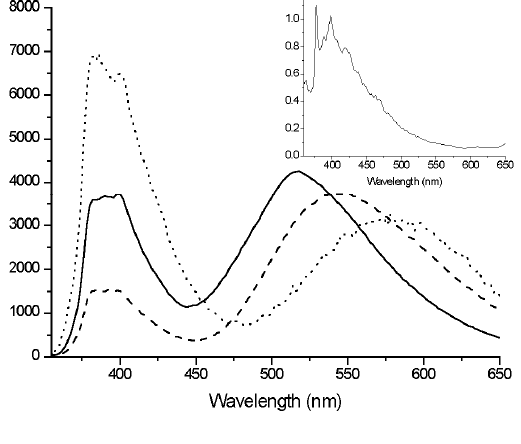
Figure 7. Normalized emission spectra of Zn(TpyPhPyrene dichloromethane (---) and in acetone ( ··· ) at room temperature (inset: spectrum at 77K in butyronitrile matrix)(  = 310 nm). ex